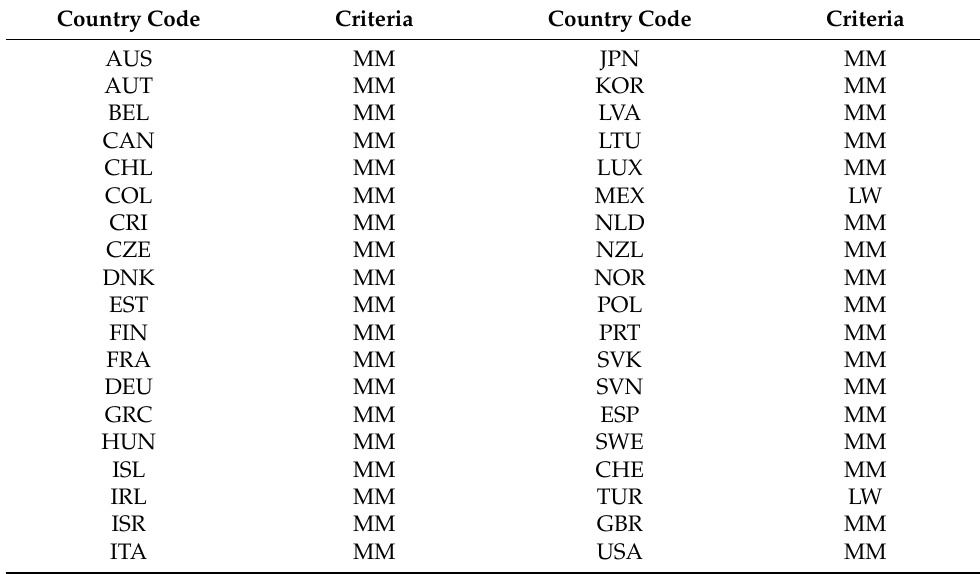
Table 17. Output Type-2 FIS variables